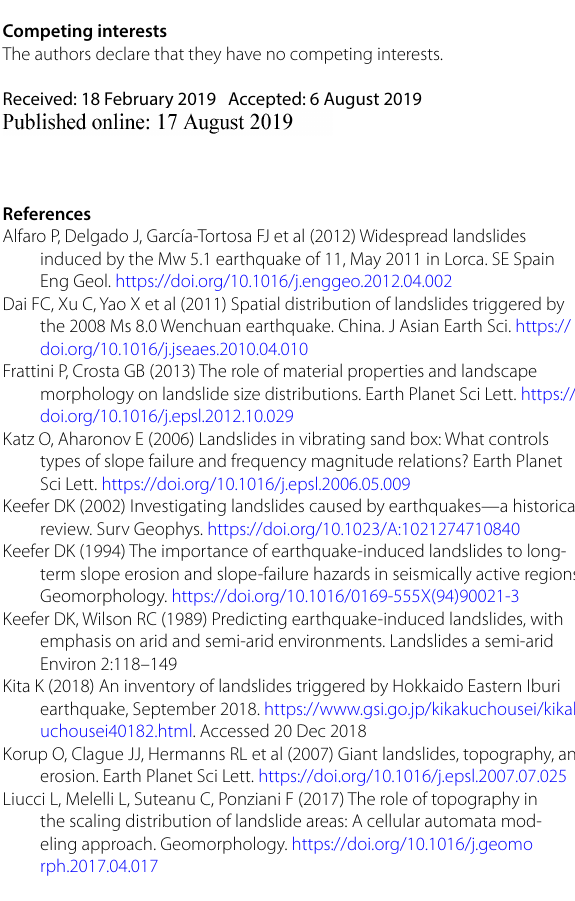
figshare repository: https ://doi.org/10.6084/m9.figsh are.95670 08. Ethics approval and consent to participate Not